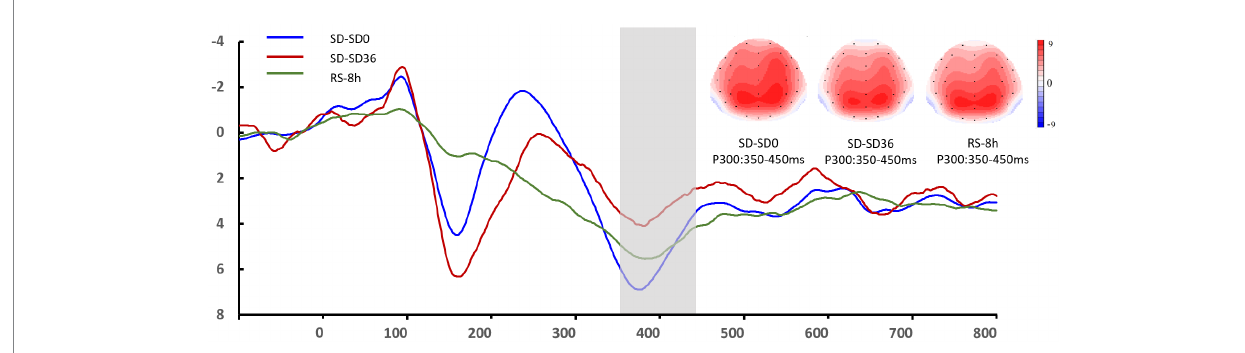
FIGURE 8 Grand mean amplitude of the P3 component in the sleep deprivation (SD) group after 0 h of sleep deprivation (SD0), 36 h of sleep deprivation (SD36), and 8 h of recovery sleep (RS-8 h). Averaged data from F3, Fz, F4, C3, Cz, C4, P3, Pz, and P4 electrodes are shown. The topographies correspond to average activity in the time windows (350–450 ms, indicated by the gray bar) around the local